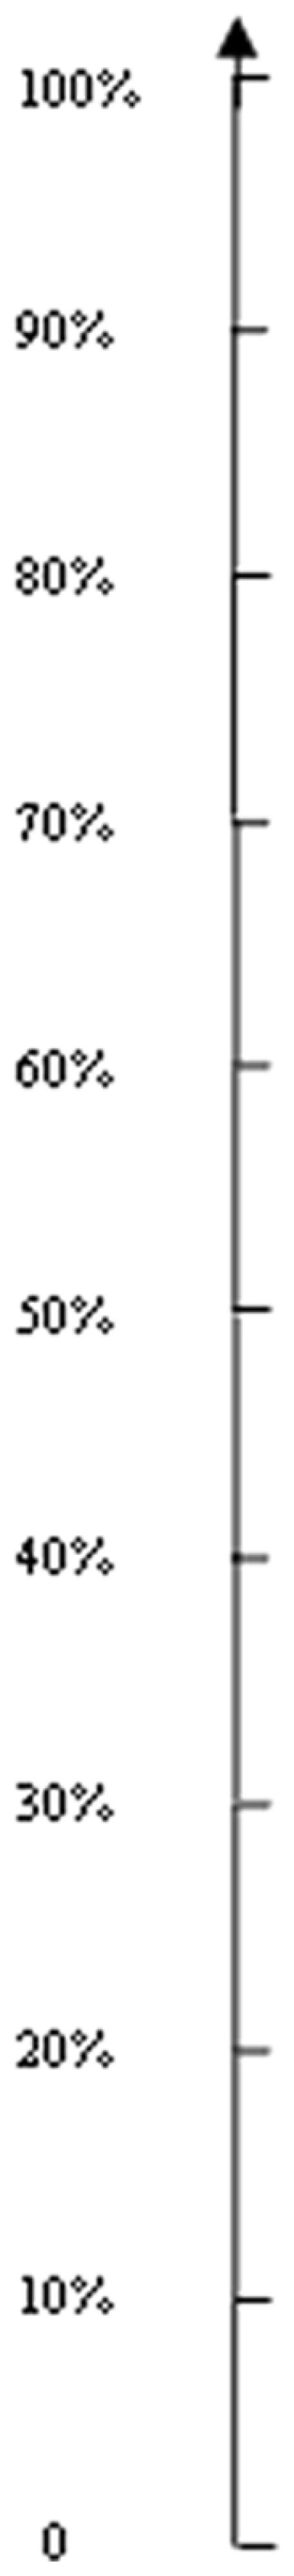
The up-version of the response scale for the ranking question in Experiment 3.